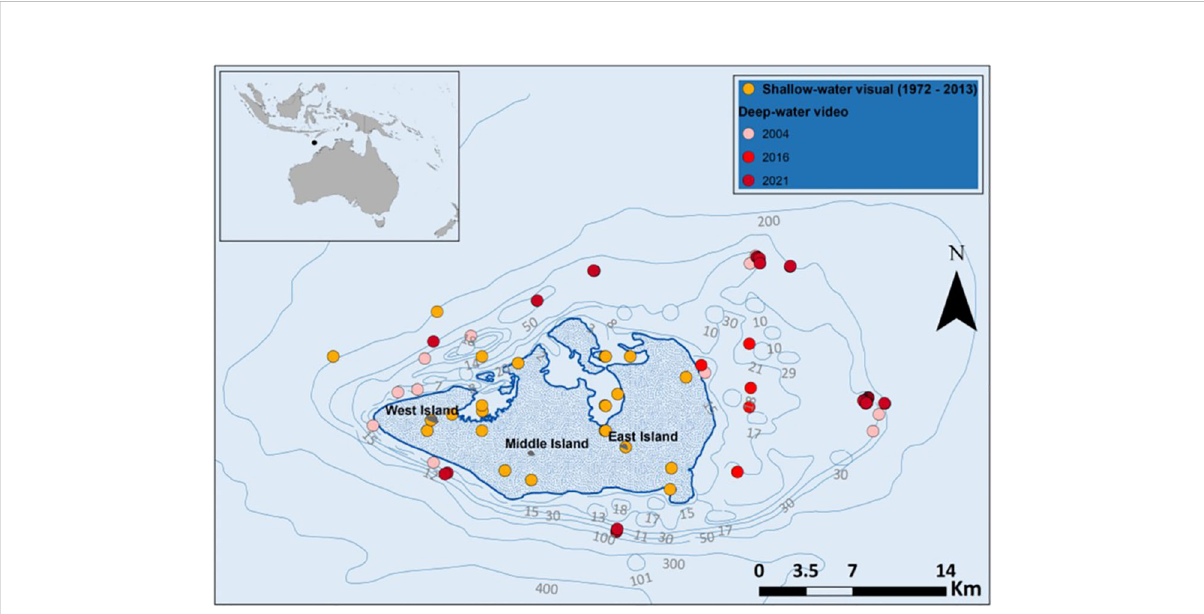
FIGURE 1 Sea snake sightings in and around Ashmore Reef. The deep-water video surveys in 2004 and 2016 were done using BRUVS, whereas the 2021 survey used an ROV. Shallow-water visual survey data downloaded from Atlas of Living Australia; occurrence download at